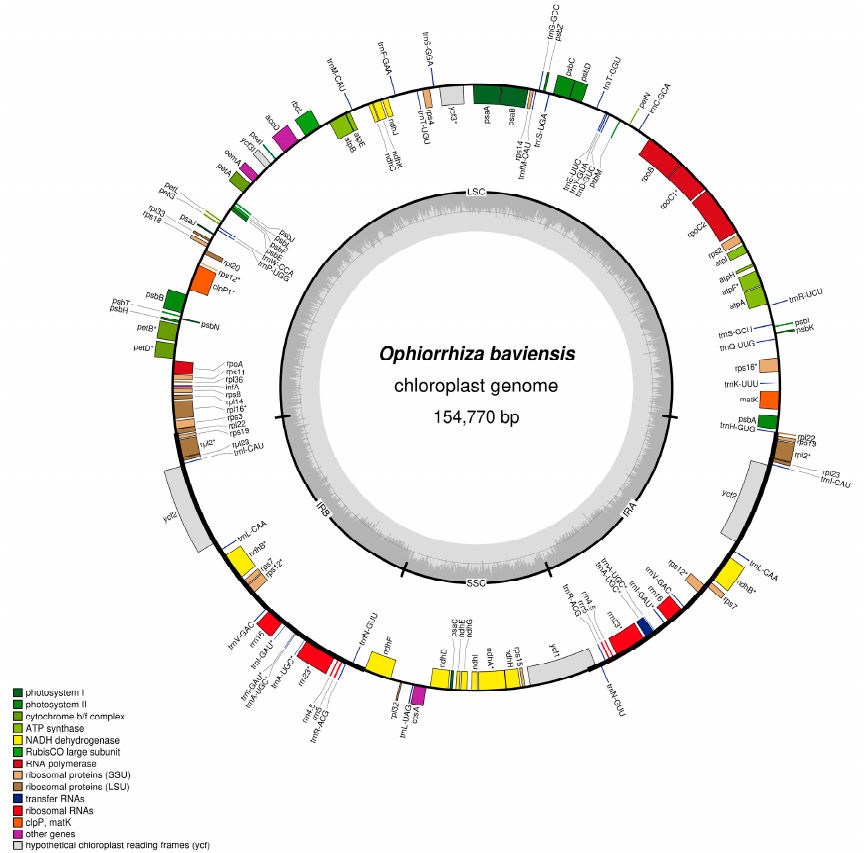
Figure 2. Chloroplast genome map of O. baviensis Drake in Vietnam. Genes shown inside the circle are transcribed clockwise, whereas genes outside are transcribed counterclockwise. The light gray inner circle shows the AT content, the dark gray corresponds to the GC content.